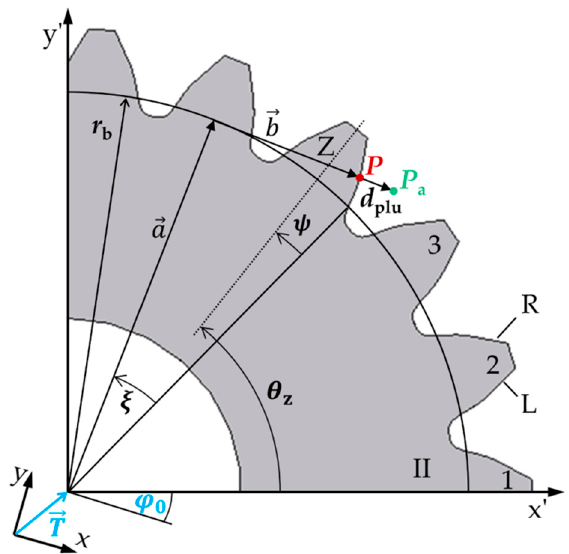
Figure 1. Geometric model for determining the shape parameter base circle radius r b of a non-modified spur gear with an involute profile, based on a measuring point P a , the root point P of the nominal gear geometry for the plumb line distance d plu and the position parameters ξ , θ z , ψ b ,(cid:1846)(cid:4652)(cid:1318),(cid:2030) (cid:2868) . Note, here, the plumb line distance of the measuring point to the nominal geometry of the gear is illustrated enlarged.